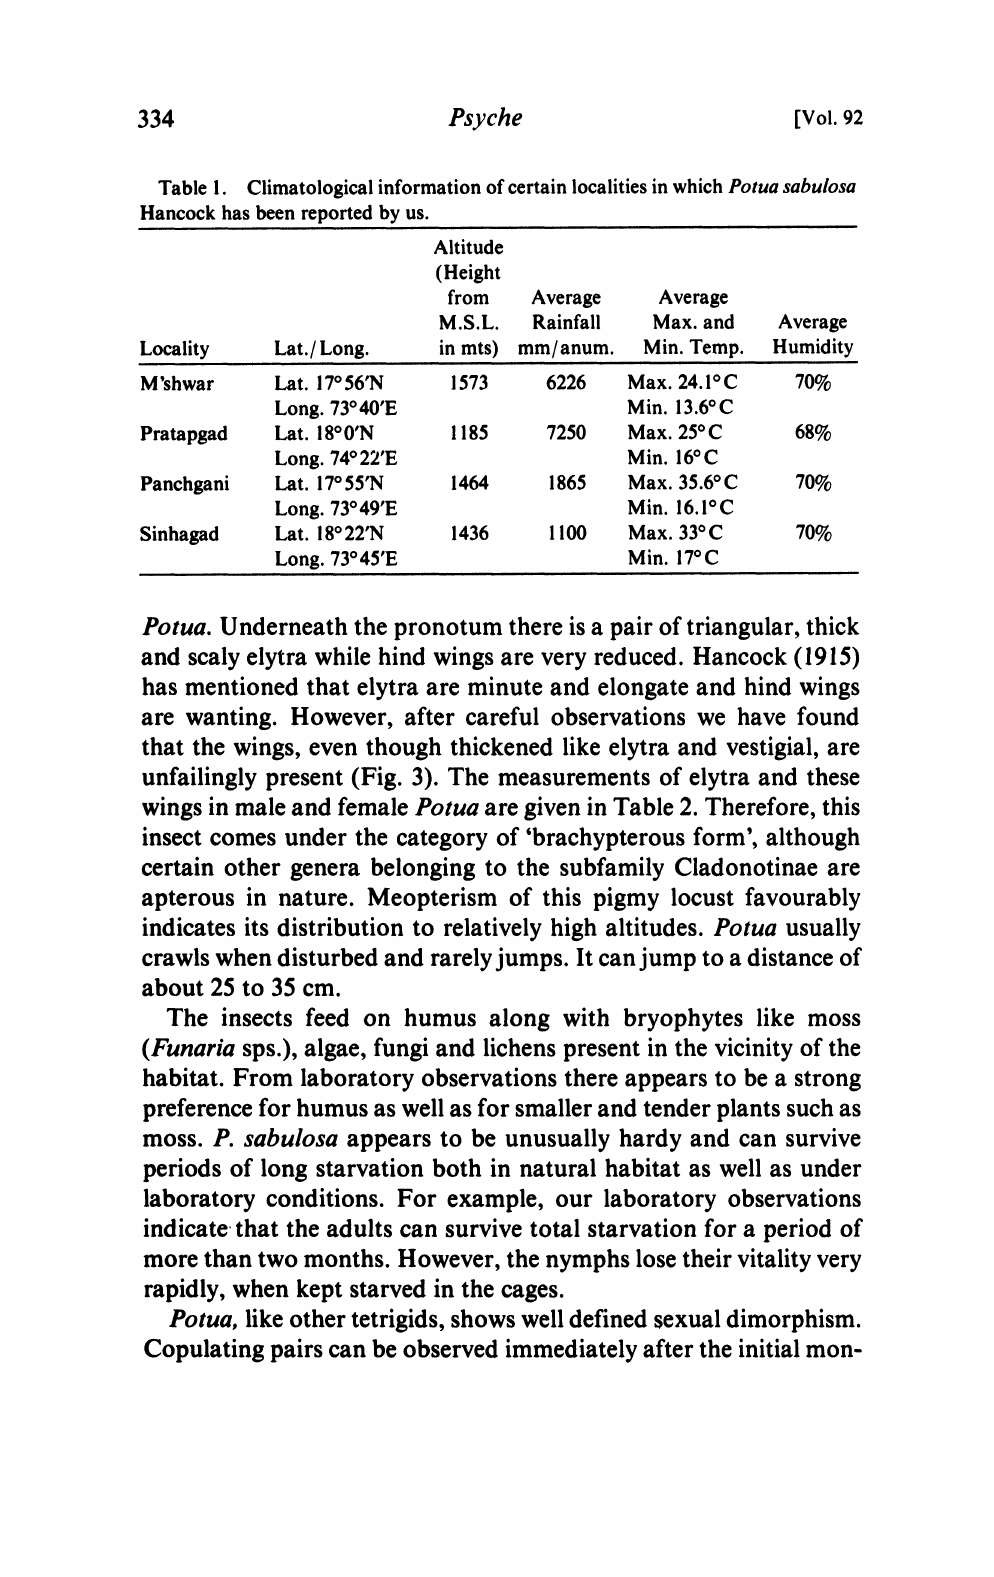
Table 1. Climatological information of certain localities in which Potua sabulosa Hancock has been reported by